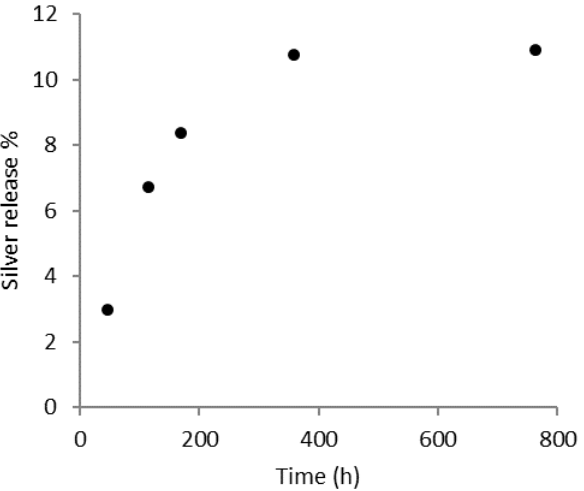
Figure 6. Silver release profile of Ag NPs/PLA (4.0 w%) in PBS at 37 °C (silver released % refers to the total amount of Ag in the fibers).